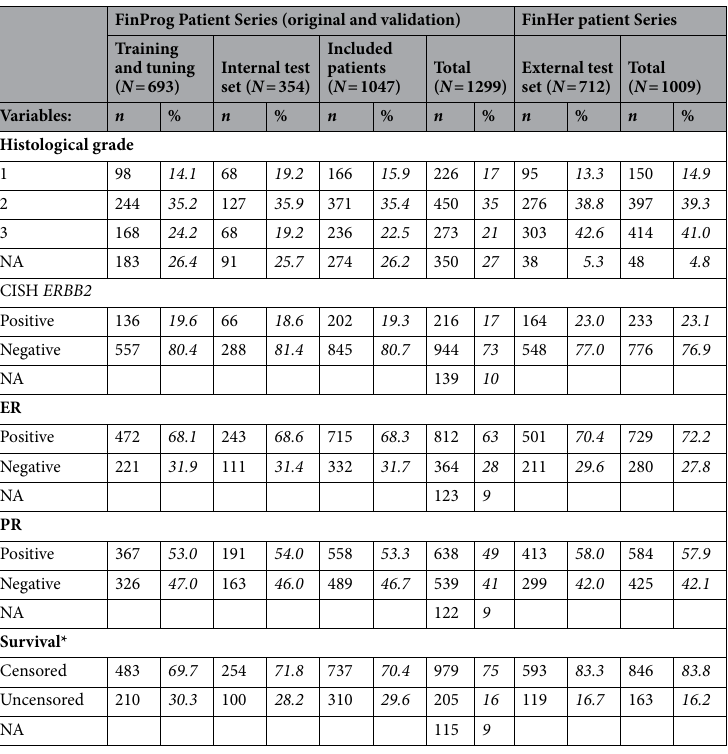
Table 1. Biological characteristics of breast cancers and patient survival. *FinProg—Breast cancer-specific survival; FinHer—Distant disease-free survival (DDFS); NA—not